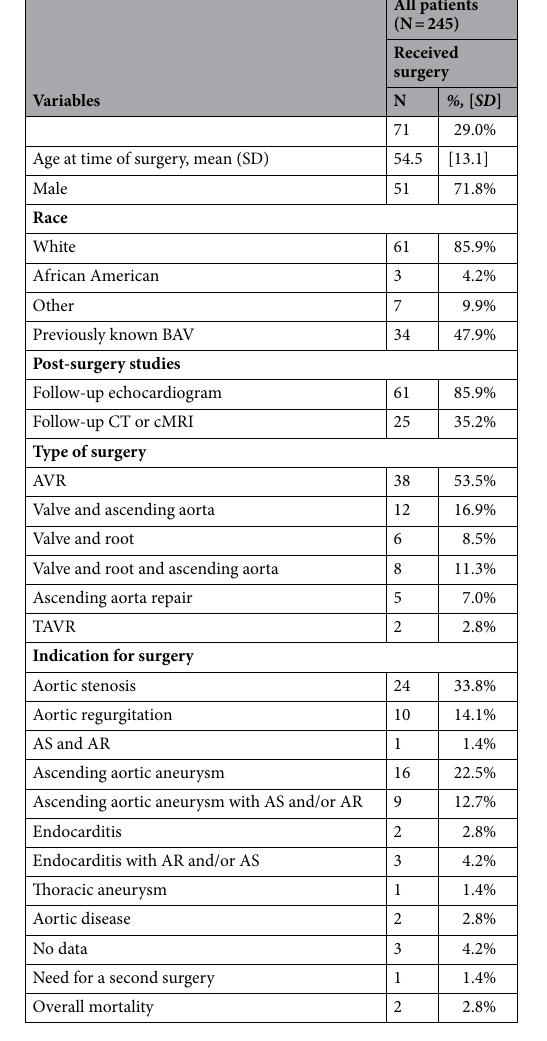
Table 3. Demographics of patients who underwent surgery. AS =aortic stenosis, AR =aortic regurgitation, AVR =aortic valve replacement, BAV =bicuspid aortic valve, CT =computerized tomography, echo =echocardiogram, cMRI= cardiac magnetic resonance imaging, Stdev or SD =standard deviation, TAVR =transcatheter aortic valve